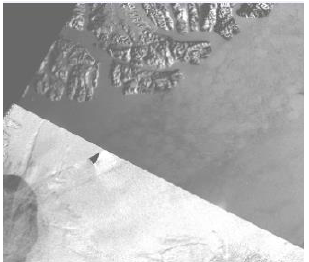
Figure.9 the remote sensing image of Greenland acquired in